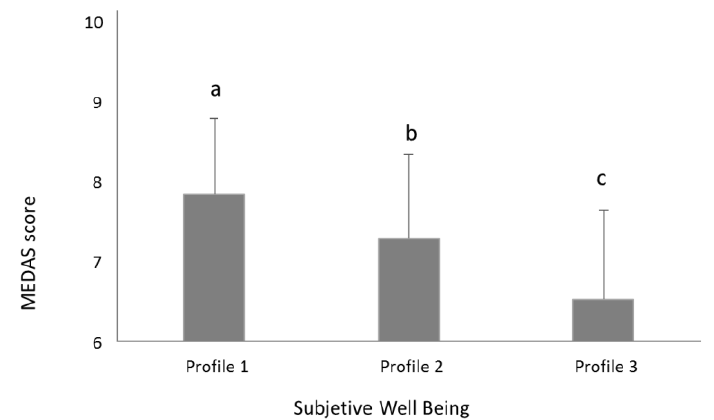
Figure 1. Adherence to the Mediterranean diet of subjects clustered in Profiles 1, 2 or 3 according to their Subjective well-being (SWB): different letters indicate significant differences between profiles ( p < 0.05). MEDAS (Mediterranean Diet adherence screener)